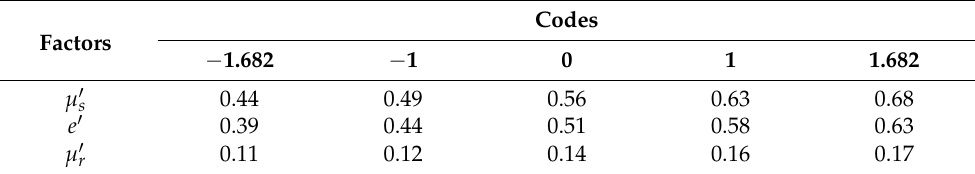
Table 2. Factors and codes of quadratic regression orthogonal rotating test.